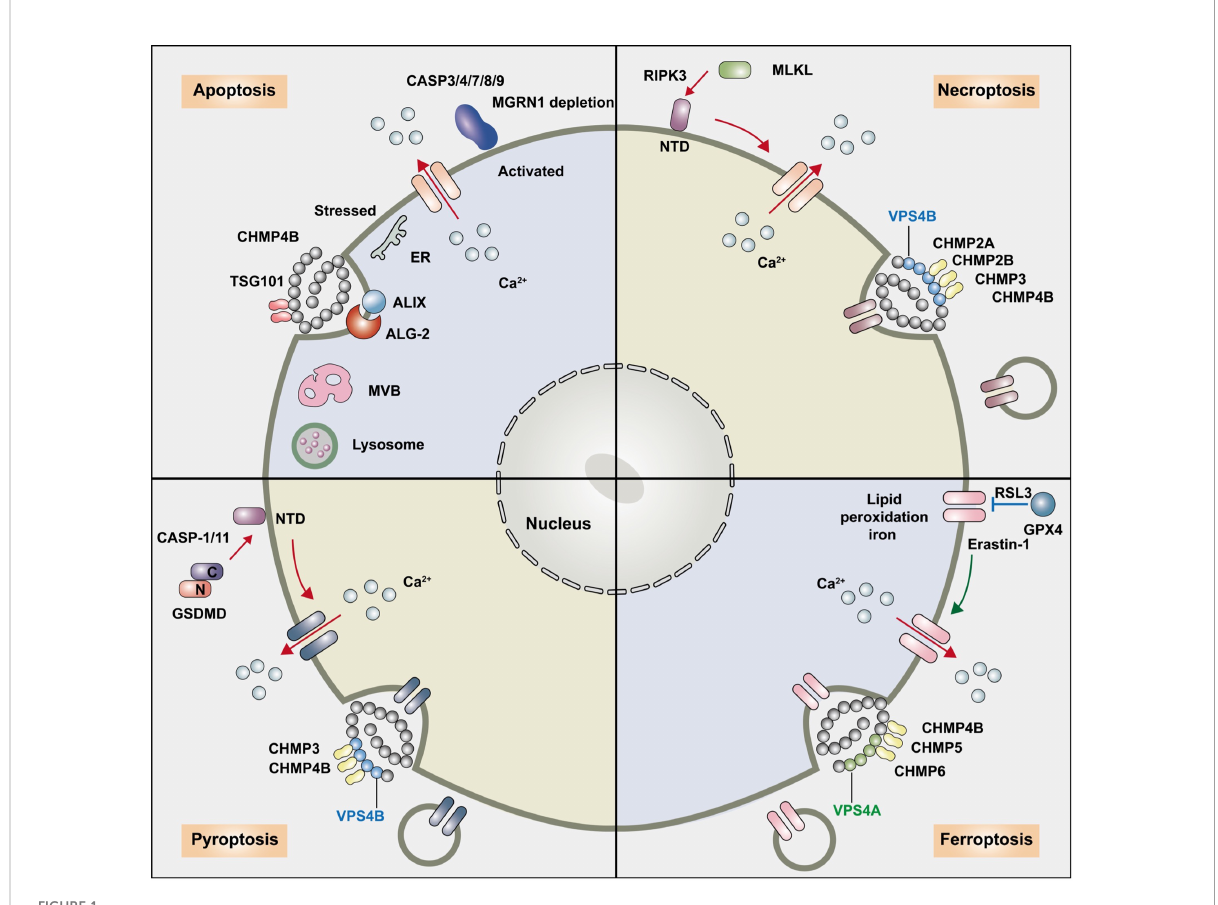
FIGURE 1 The relationship between the ESCRT pathway and regulated cell death. The endosomal sorting complex required for transport (ESCRT) machinery participates in the following regulated cell death: apoptosis, necroptosis, pyroptosis, ferroptosis and autophagy. ESCRT-I overexpression and ESCRT-III-associated charged multivesicular body protein (CHMP) 4B participate in apoptosis, and ESCRT-1 protein TSG 101 maintains low levels of ALIX and ALG-2 and prevents predisposition to apoptosis. The ESCRT-III components CHMP2A and CHMP4B are recruited to broken membrane bubble sites with the requirement of extracellular Ca2+, remove membrane vesicles from cells, and delay the time required for active MLKL to mediate necroptosis, thus preserving cell survival. CHMP4B disturbed pyroptosis by recruiting around the plasma membrane neck to remove the GSDMD pores and preserve plasma membrane integrity depending on Ca2+ in fl ux. The accumulation of the ESCRT-III subunits CHMP5 and CHMP6 in the plasma membrane is increased by the classical ferroptosis activators erastin-1 and ras- selective lethal small molecule 3 (RSL3) upon cytosolic calcium in fl ux and repairs the ferroptotic plasma